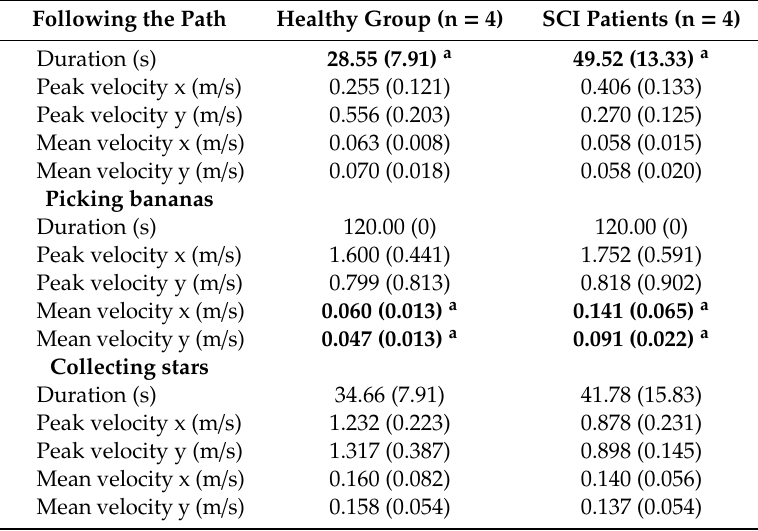
experimental groups (a, statistical di ff erences p <